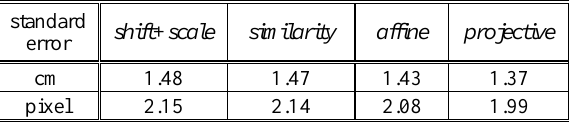
Table 2. Standard errors of 2D